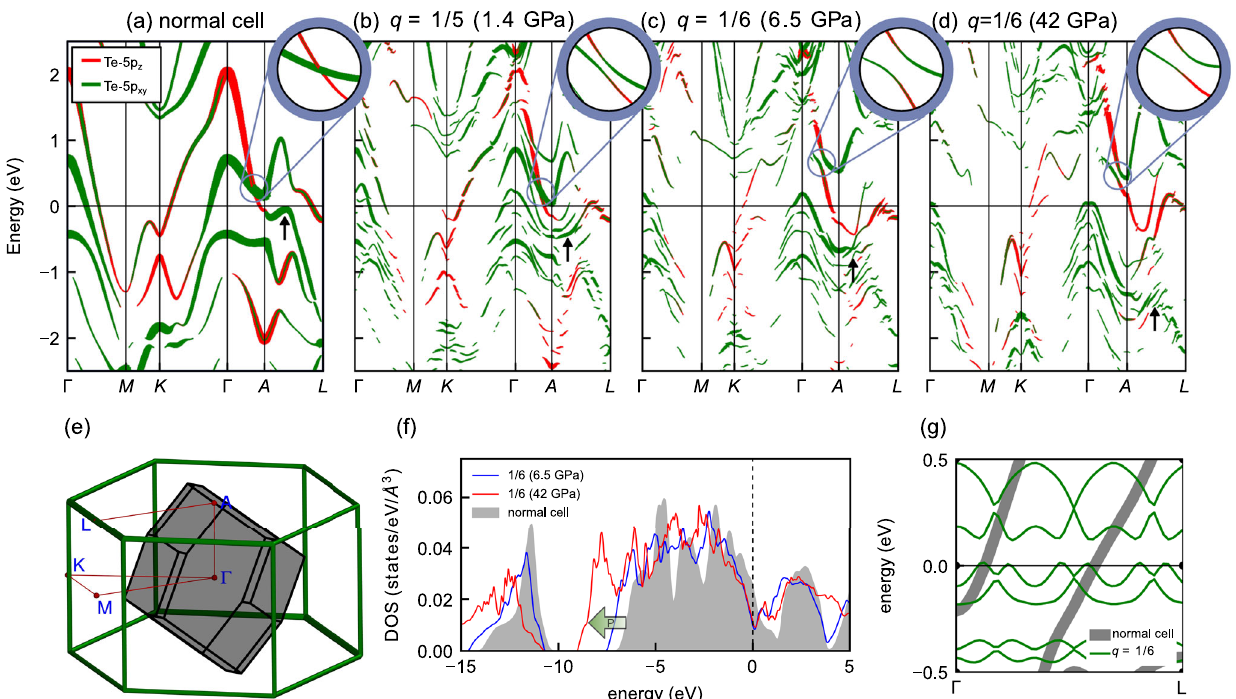
Fig. 5 Electronic structure as a function of hydrostatic pressure. a – d Fat bands representing the Te-5p character for the trigonal structure at ambient conditions ( a ), the q = 1/5 structure ( b ), and the q = 1/6 structure ( c , d ). Band weights of the q = 1/5 and q = 1/6-phase were unfolded into the Brillouin zone of the trigonal structure. A magni fi cation of the regions around the bulk Dirac point is shown in the insets. e The trigonal Brillouin zone (BZ) is depicted by green lines and the BZ of the monoclinic 1/6-phase by black lines and gray surfaces. All high-symmetry points refer to the trigonal BZ. f Total density of states (DOS) at ambient conditions (trigonal cell) and for the q = 1/6-phase at 6.5 GPa and 42 GPa. The green arrow indicates the shift of the dimer bonding states to lower energies with increasing pressure. g Comparison of the band structure along the q -direction of the 1/6-phase with the trigonal cell band structure.